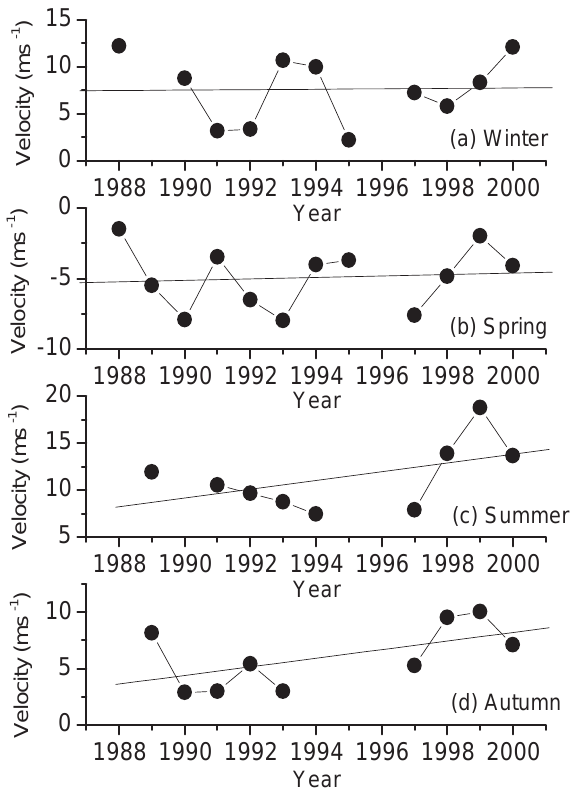
Fig. 7. Zonal seasonal-mean winds and associated linear fits. Fig. 8. Meridional seasonal mean winds and associated linear